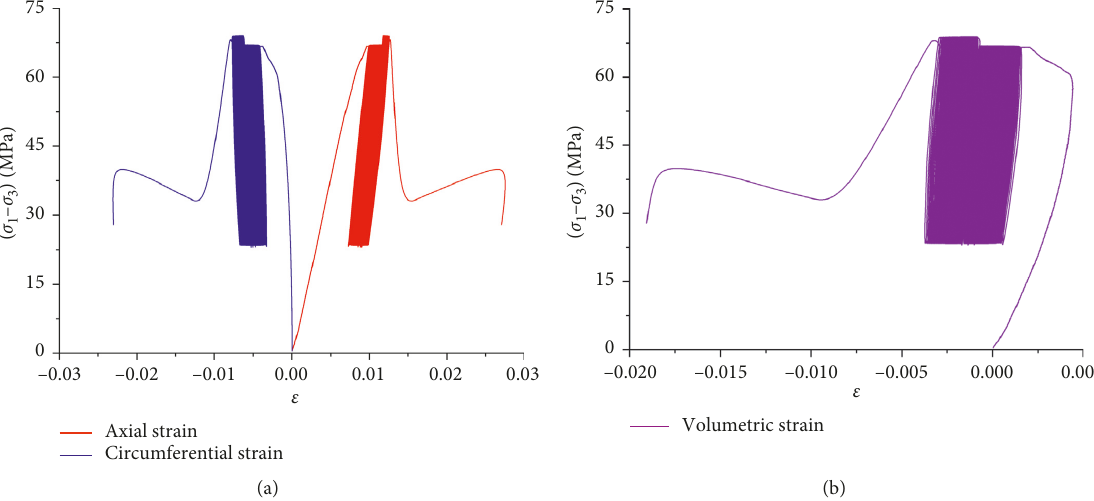
Figure 5: Deviatoric stress-strain curves of limestone sample SA. 6 in the cyclic loading test: (a) deviatoric stress-axial strain and deviatoric stress-circumferential strain curves and (b) deviatoric stress-volumetric strain curve.